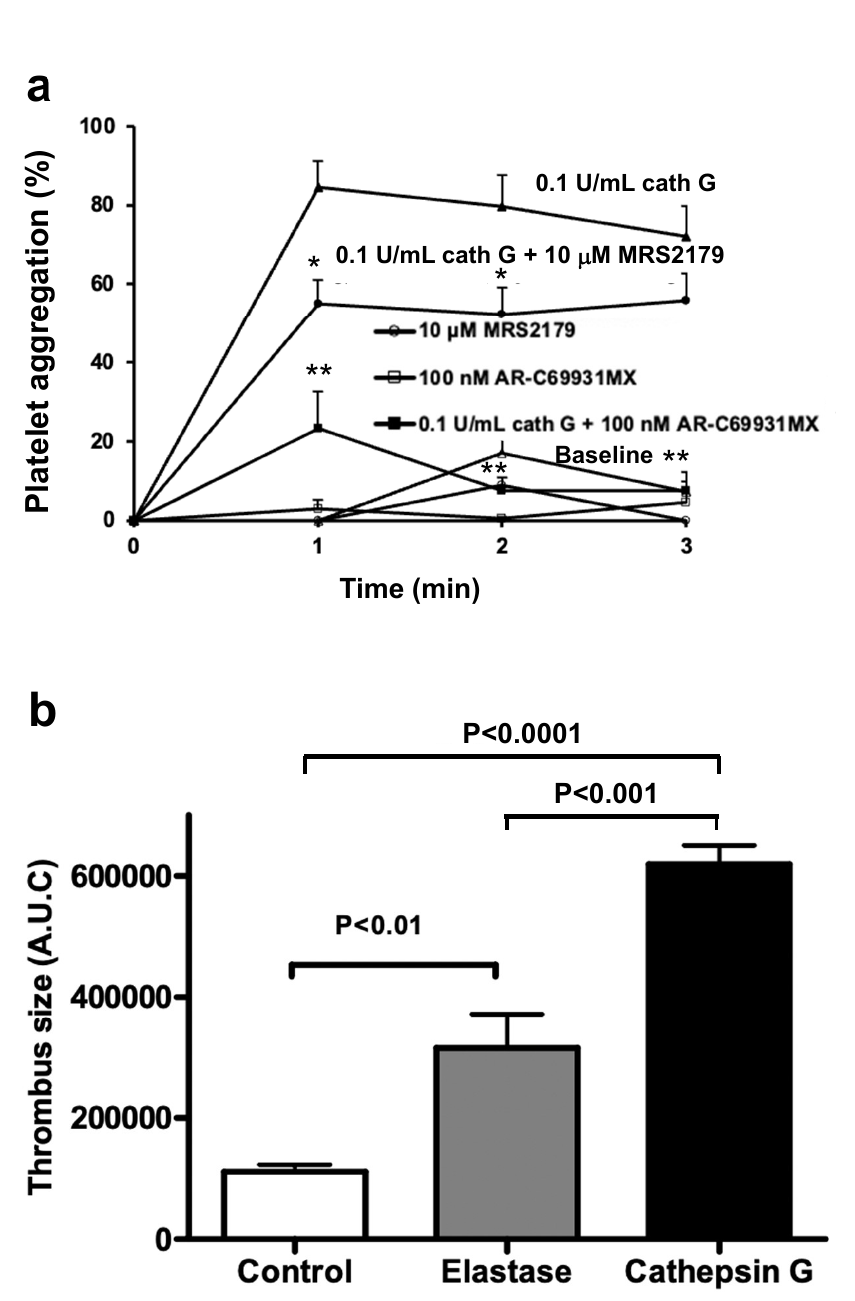
Figure 6. Murine platelet activation by elastase and cathepsin G in vitro and in vivo during experi- mental arterial thrombosis. ( a ) Platelet aggregation curves for Swiss WT mouse blood, in the absence of added agonist (Baseline, open triangles), or induced by 0.1 U/mL cathepsin G, in the absence or presence of the P2Y 1 antagonist MRS2179 or the P2Y 12 antagonist AR-C69931MX at the indicated concentrations; tracings without cathepsin G but supplemented with MRS2179 or AR-C69931MX are also shown. Platelet aggregation is calculated from residual platelet numbers at the indicated time points. ( b ) Cumulative thrombus size, expressed as total light intensity measured during 40 min (in arbitrary units [A.U.C.]), after a mild photochemical damage to the endothelium of the left carotid artery, in control Swiss mice and in mice pretreated with an i.v. bolus of elastase (24 U/kg) or cathepsin G (4 U/kg), administered 10 min before induction of photochemical injury. Data are mean ± SEM (( a ) n = 3–5 in each group; ( b ) n = 4–6 in each group). Statistical analysis was by one-way ANOVA, followed by Newman–Keuls multiple-comparison test (( a ) * p < 0.01, ** p < 0.0001 vs. tracing for 0.1 U/mL cathepsin